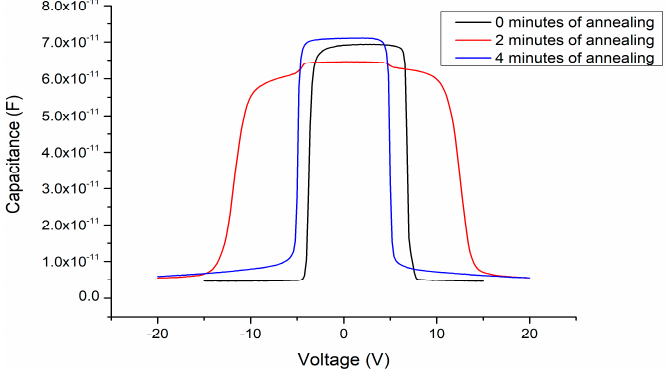
Figure 19. C–V measurement results of the MOSOM obtained using different annealing parameters.